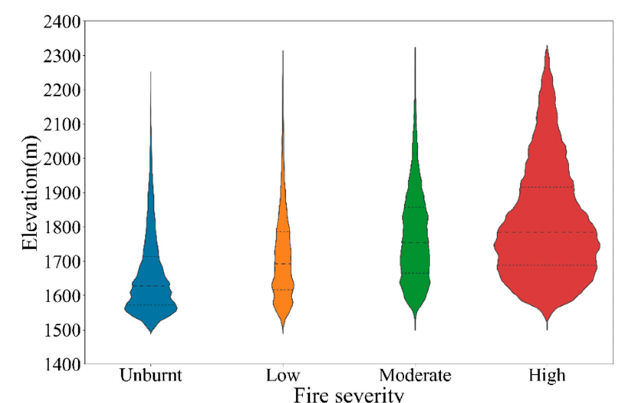
Figure 6. The distribution of elevation across each fire severity class. The violin density plots display the kernel density estimation of the underlying distribution, with the quartiles as horizontal lines (the median, the first, and the third quartile). Severity classes include unburnt, low severity (a burnt surface with unburnt canopy or partial canopy scorch), moderate severity (most or full canopy scorch), and high severity (full canopy consumption).